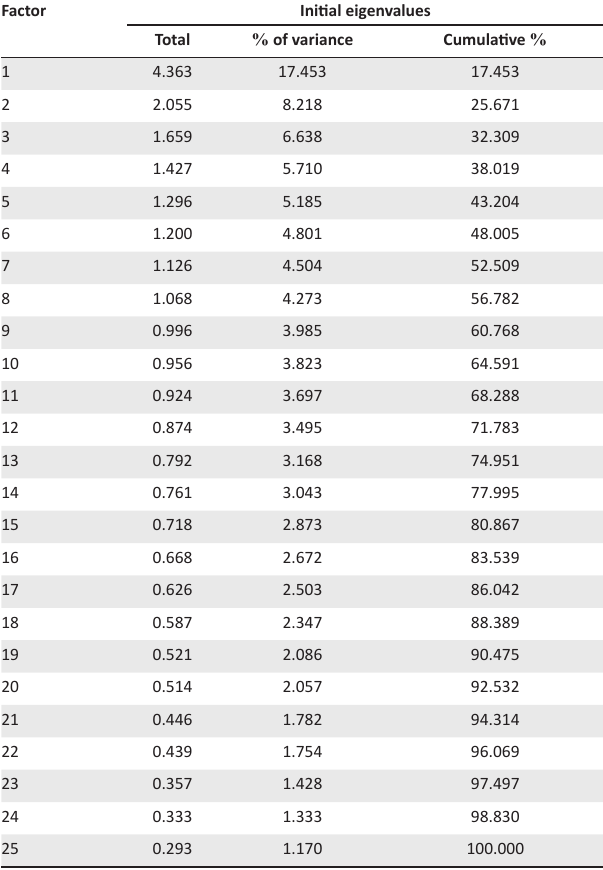
TABLE 12: Factor loadings and extracted communalities for relational capital disclosure.